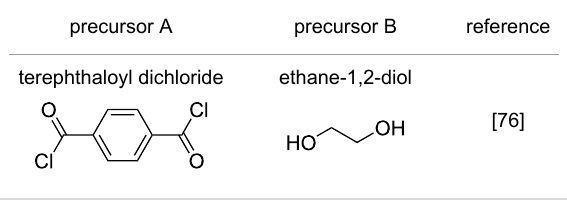
Table 9: Precursors used to deposit polyester thin